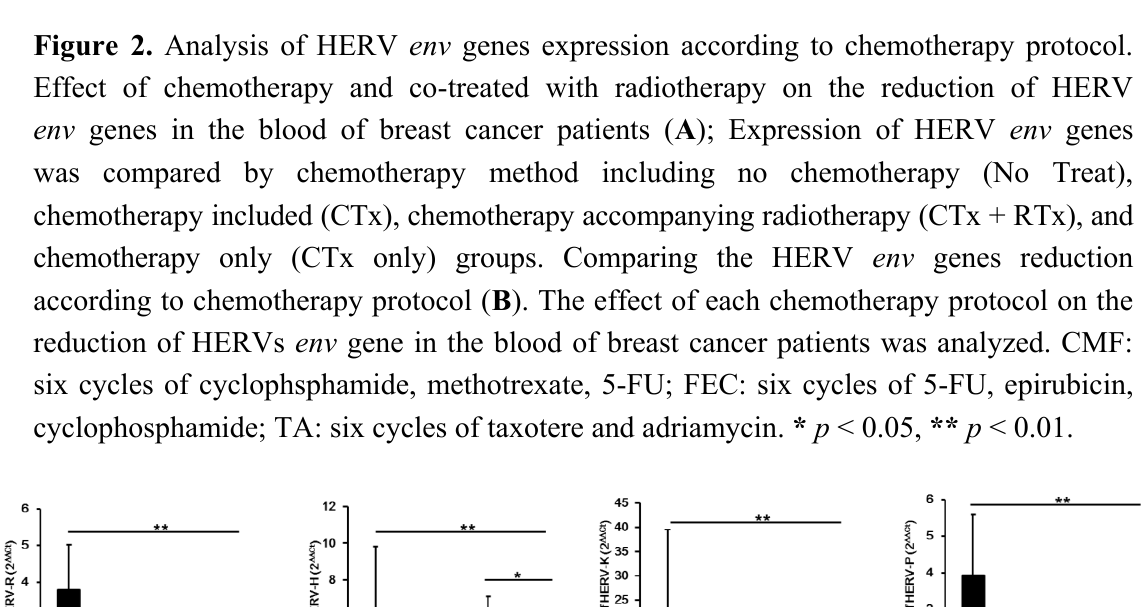
Figure 2. Analysis of HERV env genes expression according to chemotherapy